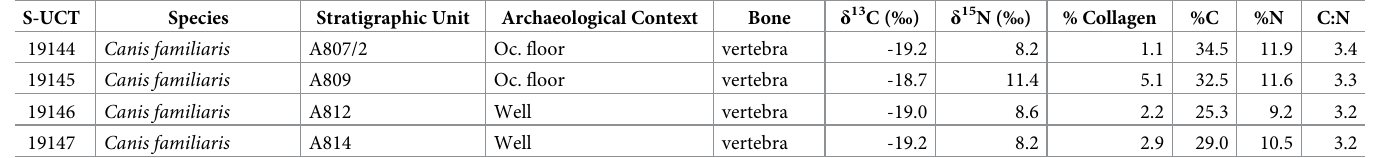
thus the marine and freshwater specific ‘baseline’ is lacking for Vila de Madrid. values of − 18.8 ± 0.5 (1 σ ) ‰ (min: − 19.7 ‰, max: − 16.9 ‰) and 10.4 ± 1.2 (1 σ ) ‰ (min: 8.6‰, max: 13.0‰), respectively. When excluding infant individuals to avoid potential inter- ference from breastfeeding (n = 23), humans from Vila de Madrid have δ 13 C and δ 15 N mean values of − 18.8 ± 0.3 (1 σ ) ‰ (min: − 19.5 ‰, max: − 17.7 ‰) and 9.9 ± 0.7 (1 σ ) ‰ (min: 8.8‰, max: 11.2‰), respectively. These values show that diet was based on terrestrial C resources. 3 They also suggest that humans were placed in a higher trophic level than herbivores and slightly higher than both domestic omnivores and the wild carnivore analysed (Fig 4). When grouped by sexes, females (n = 9) have δ 13 C and δ 15 N mean values of − 18.9 ± 0.2 (1 σ ) ‰ (min: − 19.1‰, max: − 18.7‰) and 9.5 ± 0.4 (1 σ ) ‰ (min: 8.8‰, max: 10.1‰) respec- tively, while males (n = 14) show δ 13 C and δ 15 N mean values of − 18.8 ± 0.4 (1 σ ) ‰ (min: − - 19.5‰, max: − 17.7‰) and 10.1 ± 0.7 (1 σ ) ‰ (min: 8.8‰, max: 11.2‰) respectively. When grouped by age categories, the Newborn-Infant I age category (n = 14) have δ 13 C and δ 15 N mean values of − 18.4 ± 0.6 (1 σ ) ‰ (min: − 19.1‰, max: − 16.9‰) and 11.6 ± 1.3 (1 σ ) ‰ (min: 9.1‰, max: 13.0‰) respectively, individuals from the Infant II category (n = 4) show δ 13 C and δ 15 N mean values of − 19.5 ± 0.2 (1 σ ) ‰ (min: − 19.7‰, max: − 19.2‰) and 9.3 ± 0.8 (1 σ ) ‰ (min: 8.6‰, max: 10.4‰) respectively, Young Adults (n = 8) have δ 13 C and δ 15 N mean values of − 18.9 ± 0.2 (1 σ ) ‰ (min: − 18.5‰, max: − 19.1‰) and 9.7 ± 0.7 (1 σ ) ‰ (min: 8.8‰, max: 10.8‰) respectively, and Adults (n = 15) show δ 13 C and δ 15 N mean values of − 18.8 ± 0.4 (1 σ ) ‰ (min: − 17.7‰, max: − 19.5‰) and 10.0 ± 0.6 (1 σ ) ‰ (min: 9.1‰, max: 11.2‰) respectively.